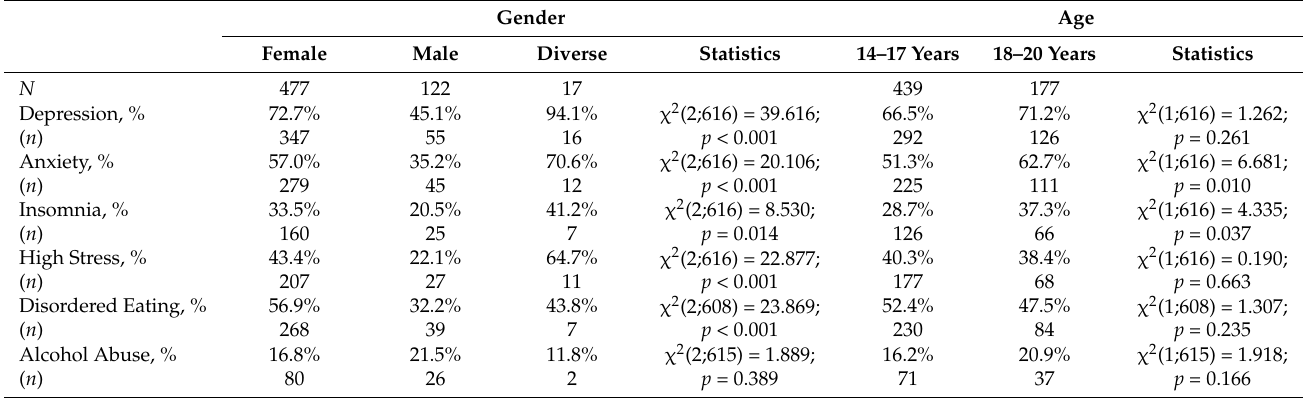
Table 1. Mental health indicators by gender and age.